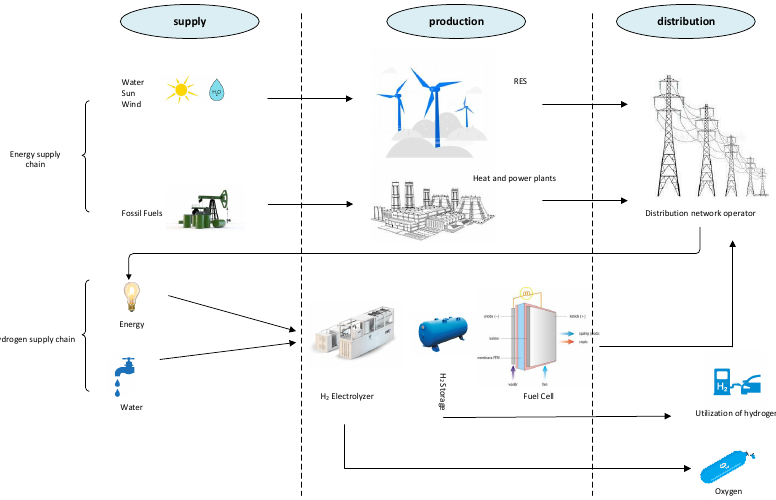
Figure 2. Energy supply chain collaborating with hydrogen supply chain. Source: